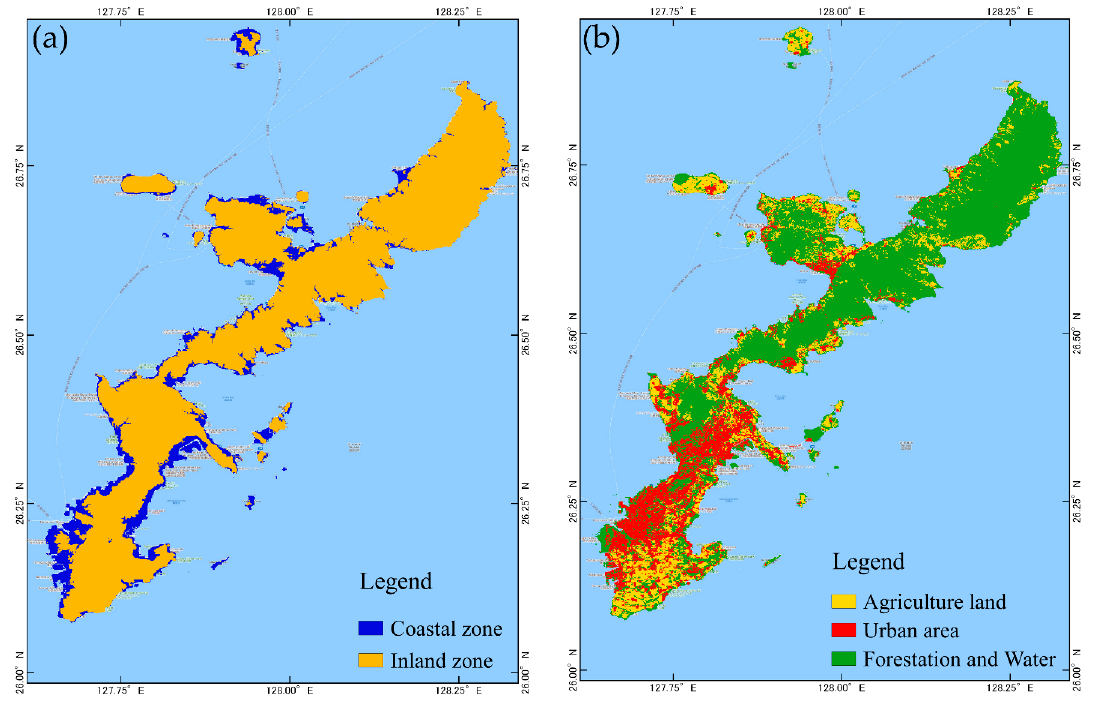
Figure 6. Parameters used to construct the MRIO, ( a ) is the topographical characteristic and ( b ) is the economic land use type.